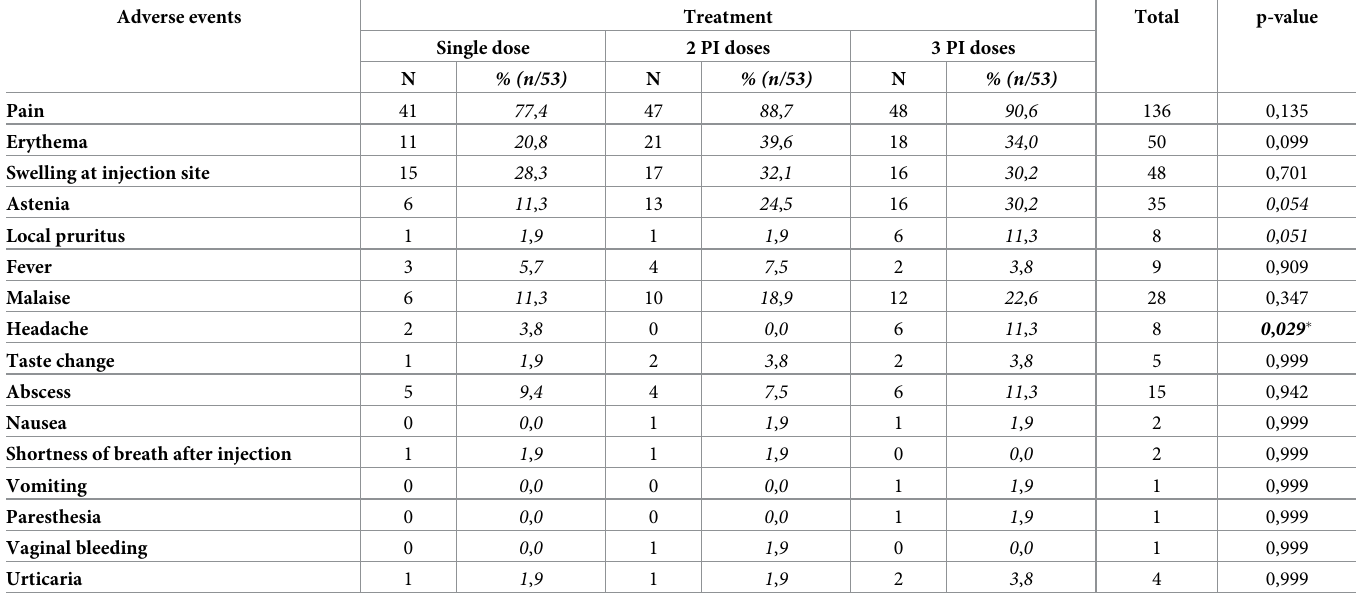
Table 4. Adverse events six months after treatment according to the treatment group of ACL patients in Manaus in 2013–2015.